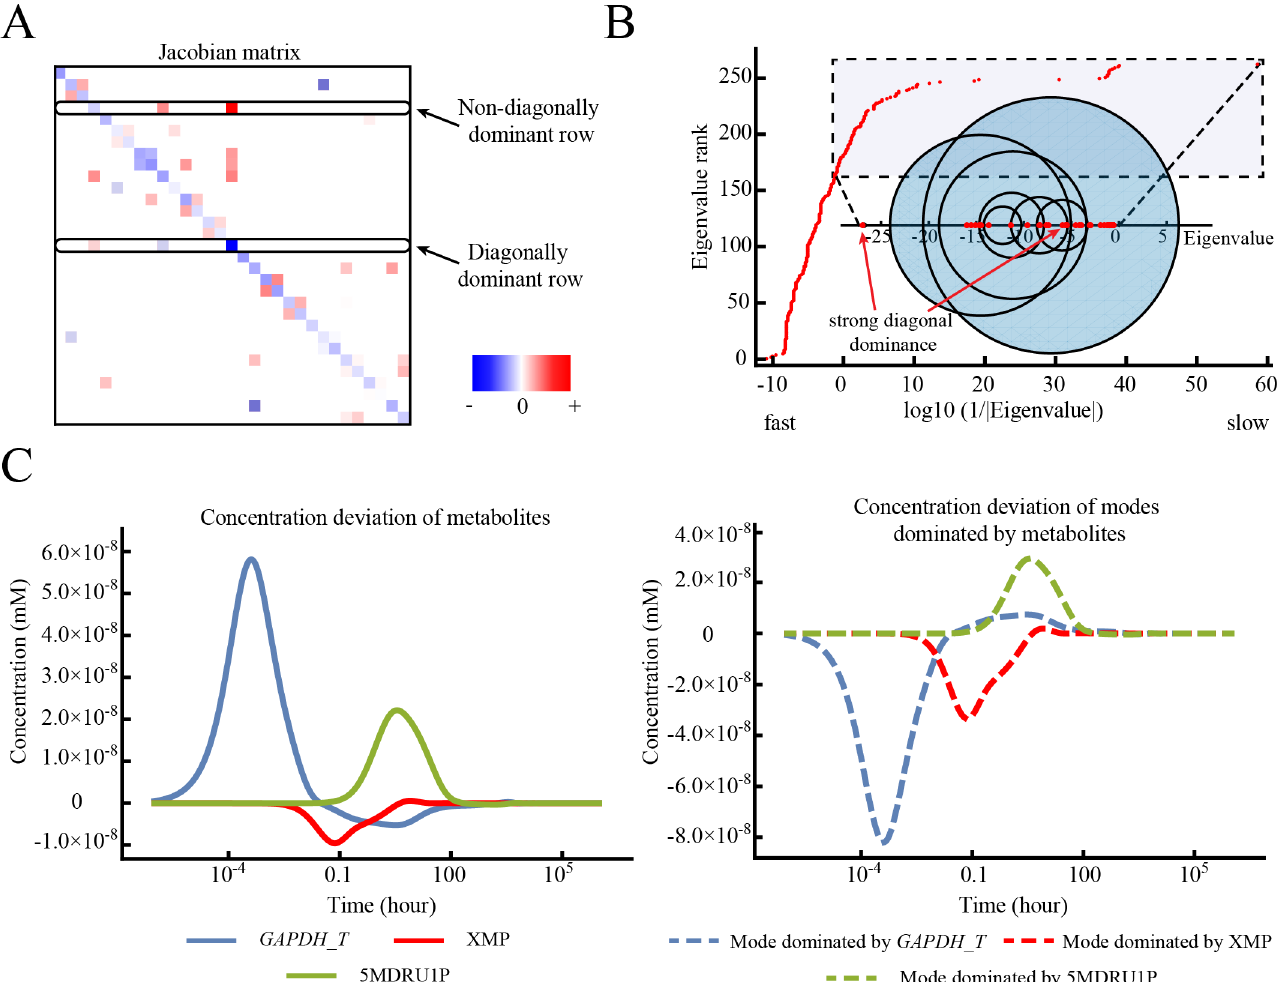
Fig 2. Diagonal dominance in the Jacobian matrix explains simple mode structuresand corresponding eigenvalues with the help of Gershgorin circle theorem. (A) ExampleJacobianmatrix of the RBC metabolicnetwork [23] with different degreesof diagonaldominance. The Jacobianmatrix of the metabolicnetworkhas a sparse structure, and the diagonalelementsof the matrix are always negativedue to the structure of the rate laws used. The matrix was extracted from the full concentration Jacobianmatrix for illustrative purposes. (B) The entire set of eigenvaluesof the Jacobianmatrix is shown in the larger plot, with x-axis denoting the inverse of absolute eigenvalues at the log10 scale. In the inset, selected Gershgorincircles of the Jacobianmatrix with circle centers rangingfrom -27 to -5 are shown for illustrative purposes. Eigenvaluesgreater than -27 are drawn together with the selectedcircles. The Gershgorin circles from rows with strong diagonal dominance have centers at -26.2 and -5.26 as shown, and the eigenvalues inside are -26.3 and -5.33. All eigenvalues are negativeas the system is dynamically stable. The imaginarycomponents of the eigenvaluesare small and therefore are neglected. (C) The dynamic responseof GAPDH_T , XMP, 5MDRU1P, comparedto the respective modes dominated by these metabolites/enzymes, under an ATP hydrolysisperturbation. The dynamics of the mode dominated by a single metabolitecoincidewith the dynamicsof that metabolite. These modes occur at fast, intermediate and slow timescales, showingthat diagonal dominancecan occur at any time as long as the structural propertiesof the Jacobianmatrix allow.